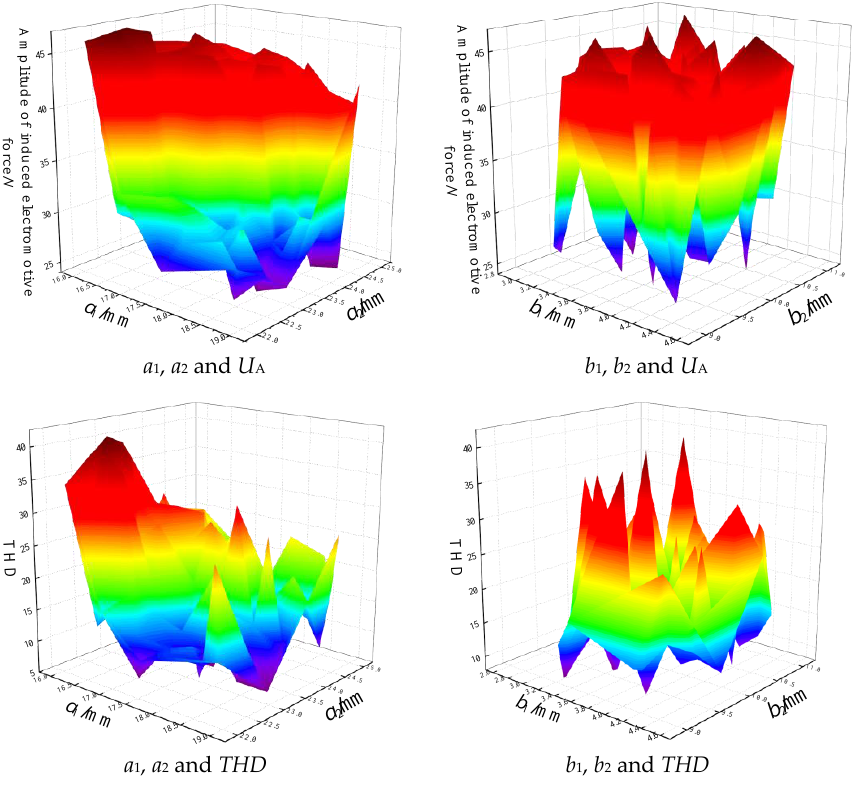
Figure 11. Part of the design variable fits the response value. Table 4. Sensitivity of the design variable with respect to the response value. Design Variables